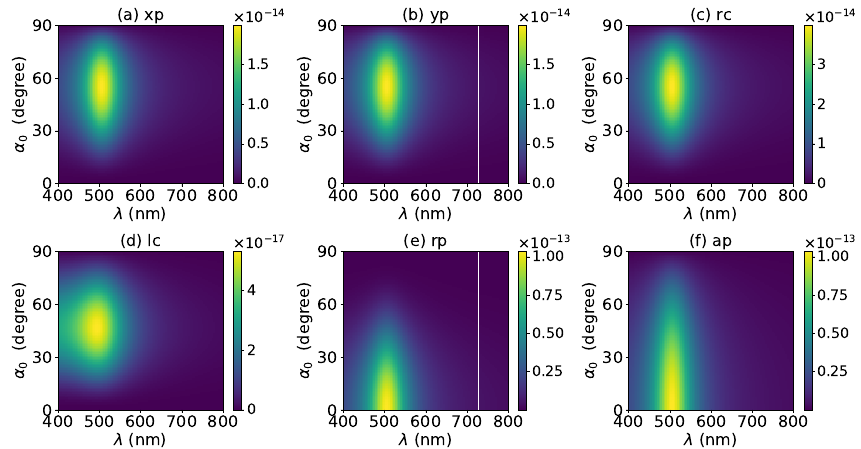
Figure 11. The same as in Figure 7, but with N = 4.